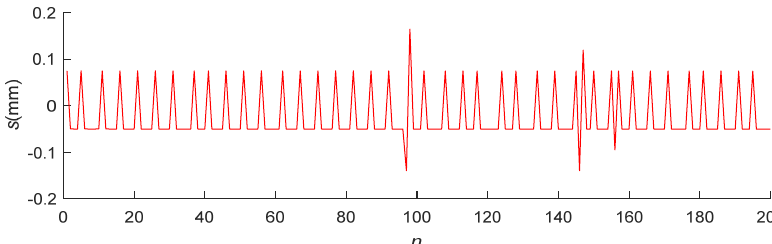
Figure 27. Position detection error of the pose measurement system.